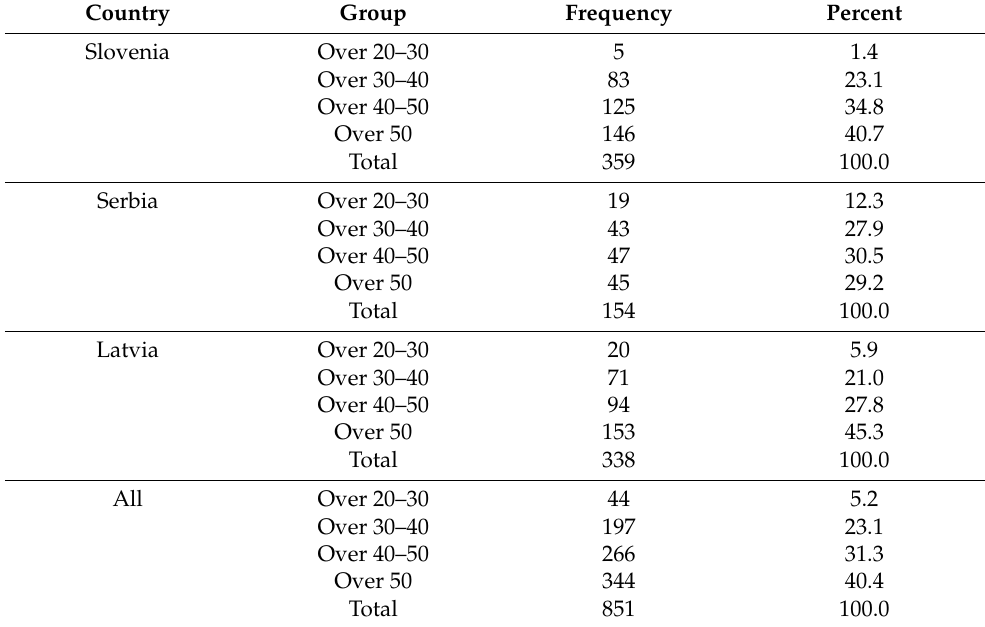
Table A10. Age of the person (in years).